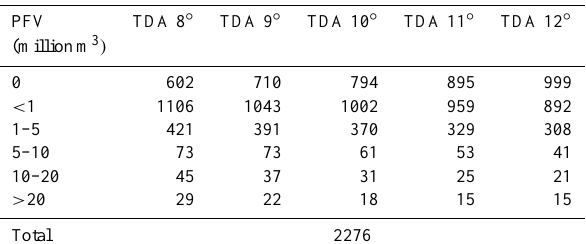
Table 4. Number of Himalayan glacial lakes categorized by poten- tial flood volume (PFV) resulted from different threshold depression angles